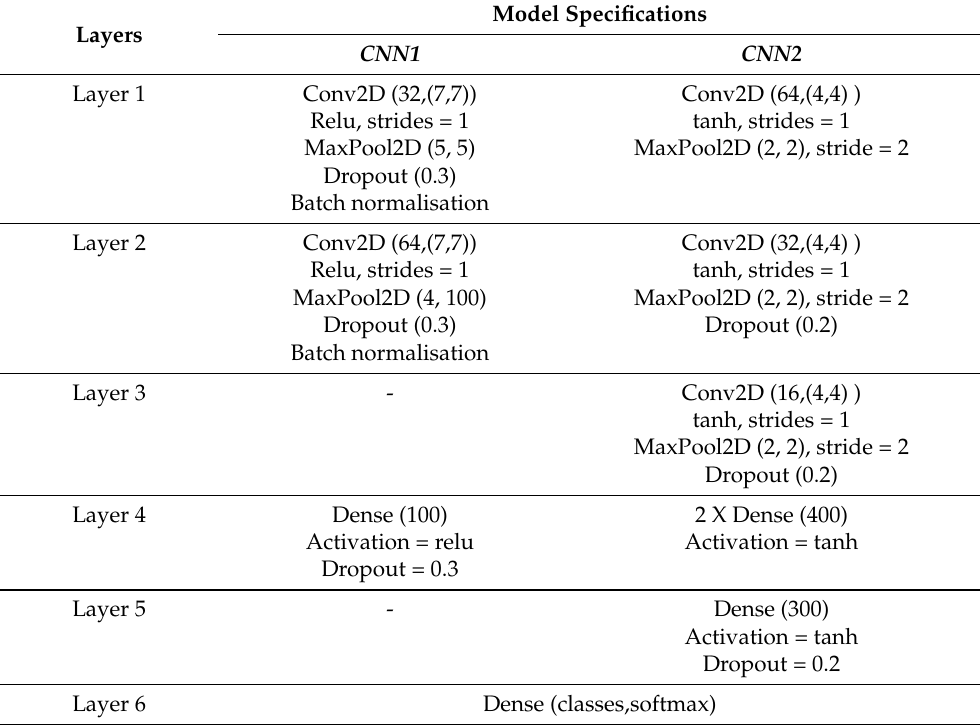
Table 1. Convolutional neural network model specification.